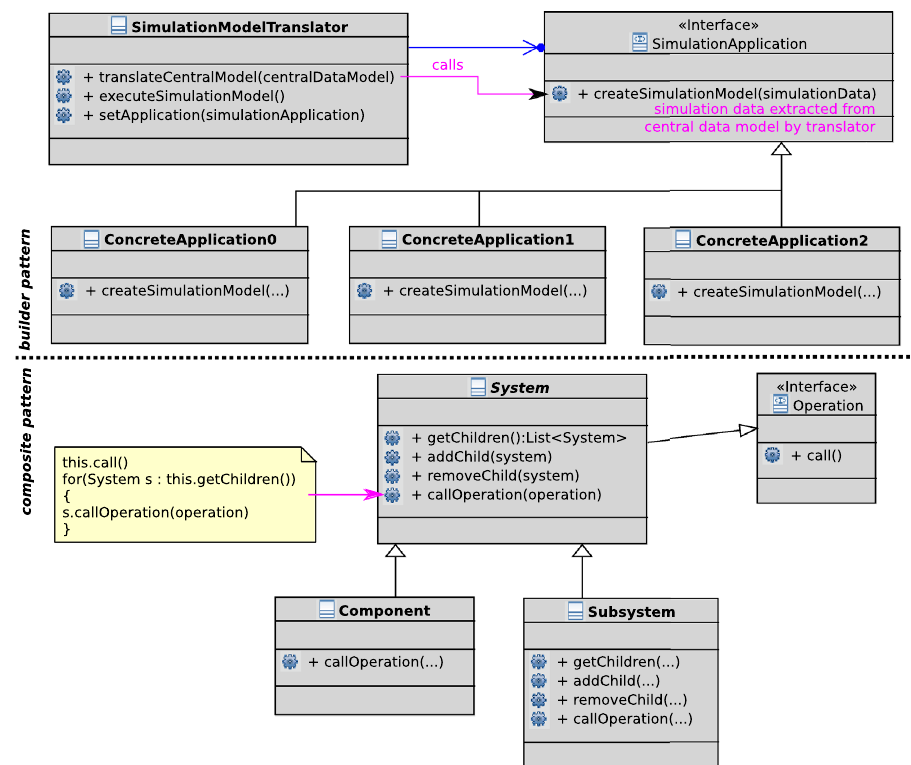
Fig. 17 Two design patterns from object-oriented software engineering. Top: Builder pat- tern to translate the domain- relevant information in the central data model to different simulation applications (imple- mentation of process chains in Fig. 2). Bottom: Composite pattern to model systems- of-systems relationships in systems